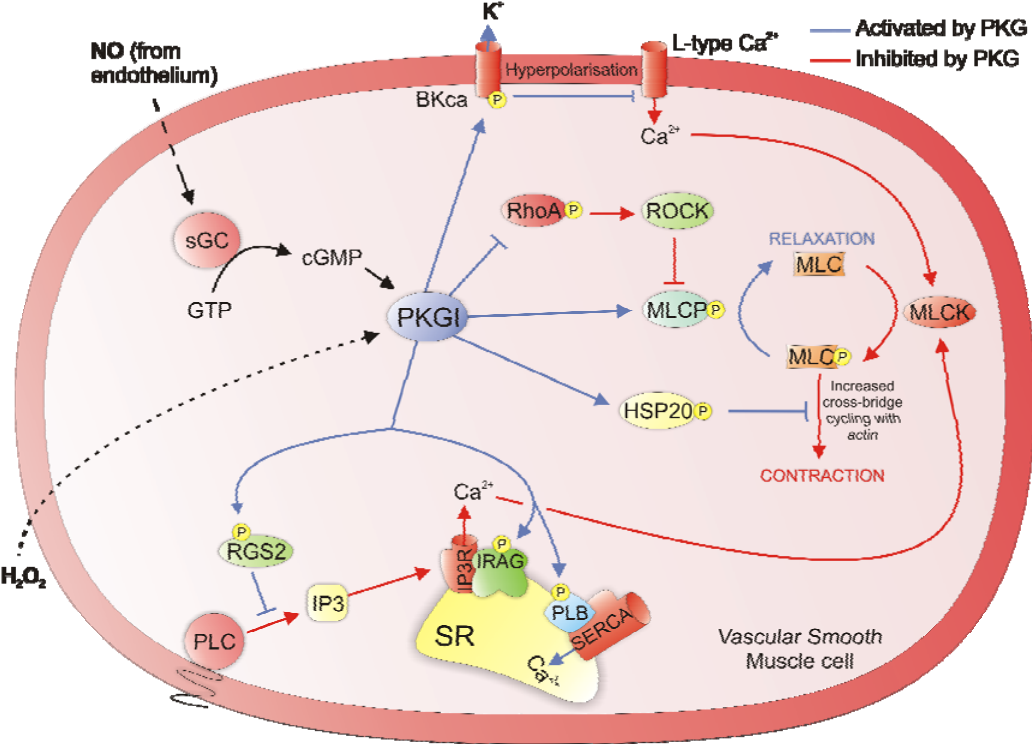
Figure 3. The biochemical targets of PKG in vascular smooth cells that mediate